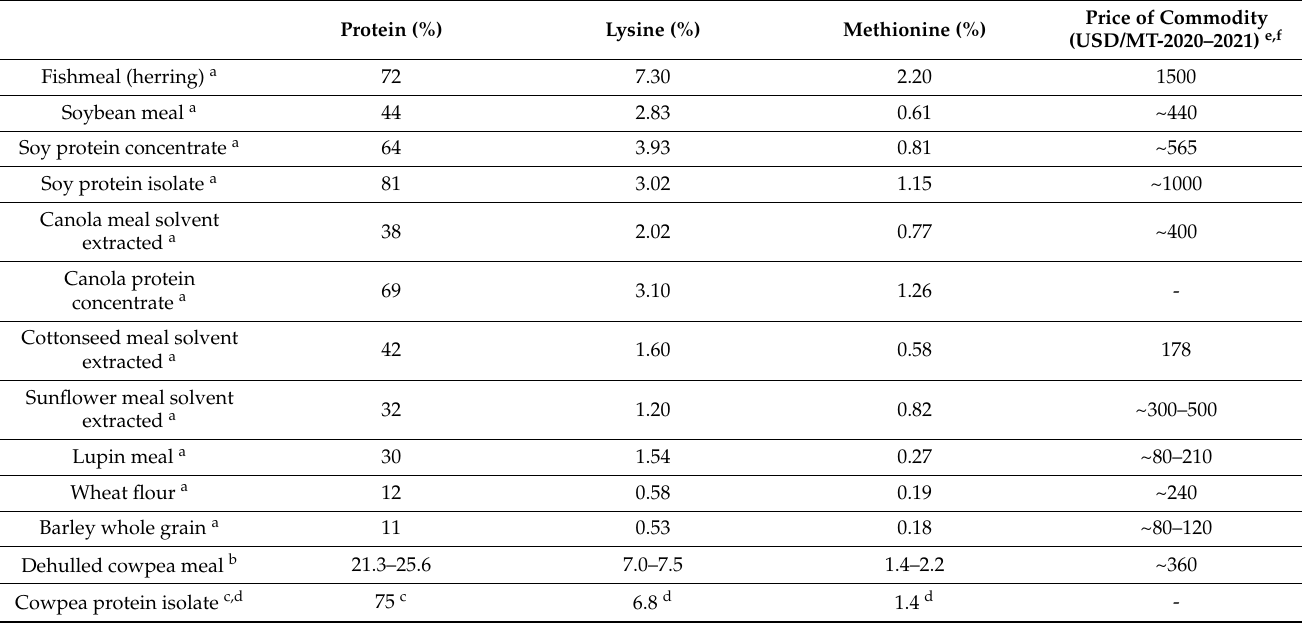
Table 4. Average protein, lysine and methionine content, and price of fishmeal and selected plant-based ingredients. Protein (%) Lysine